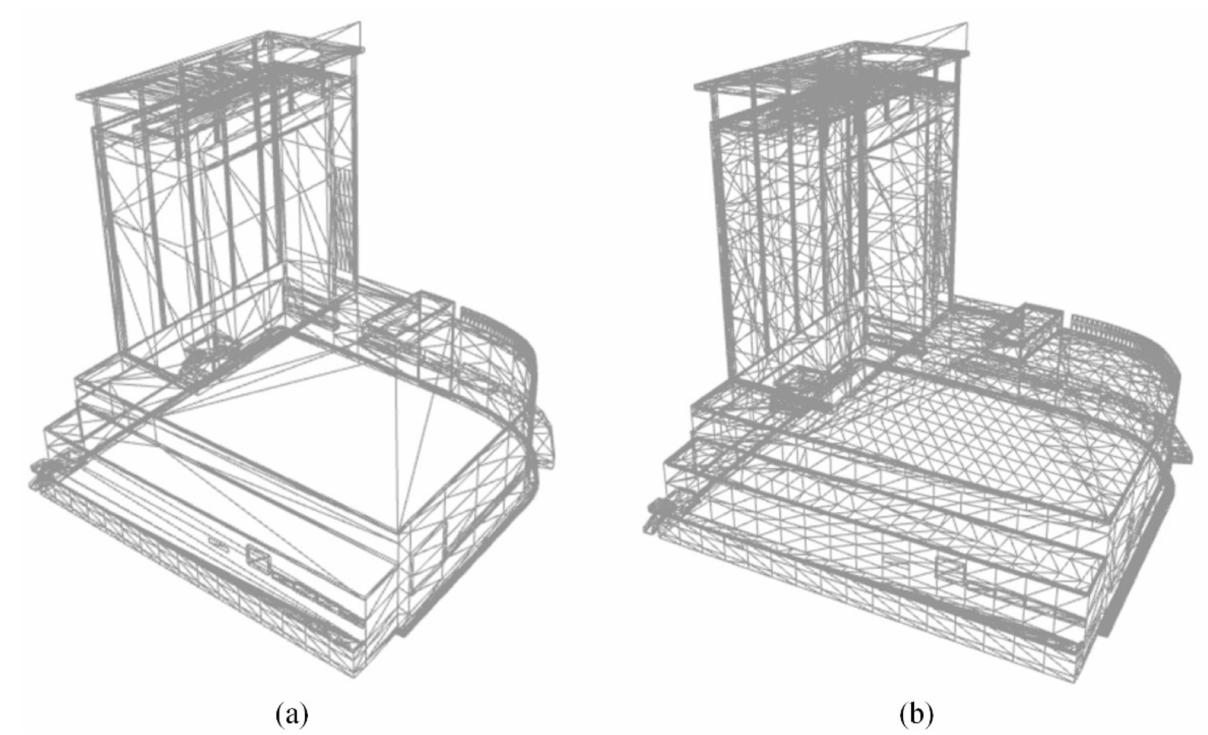
Figure 10. Geometric mesh: ( a ) original mesh and ( b ) clipped